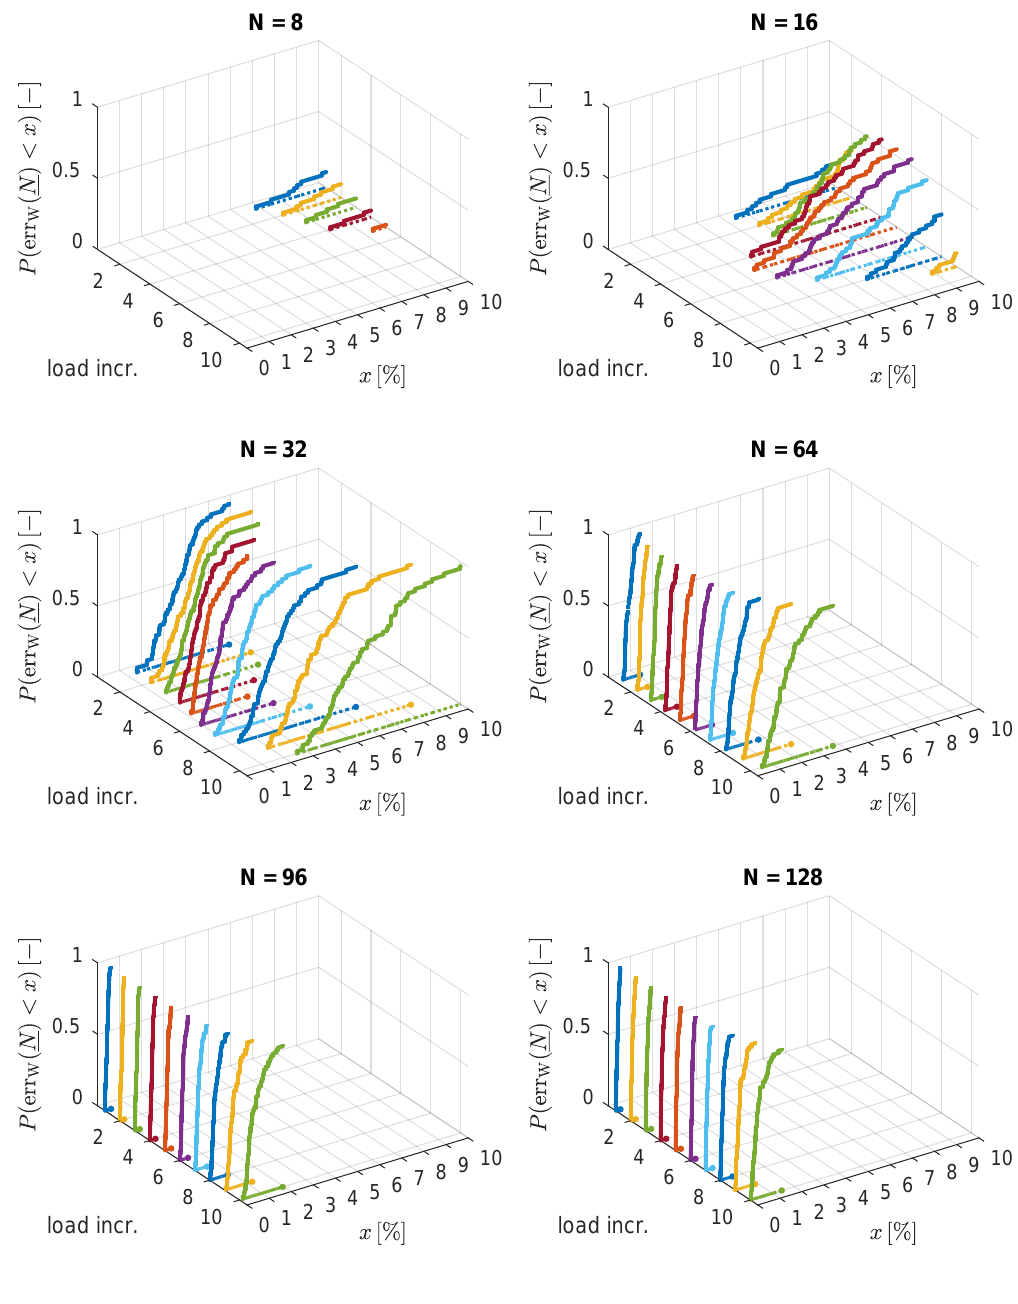
Figure 6. Cumulative energy error distribution per direction for the RB of the fibrous microstructure under validation boundary